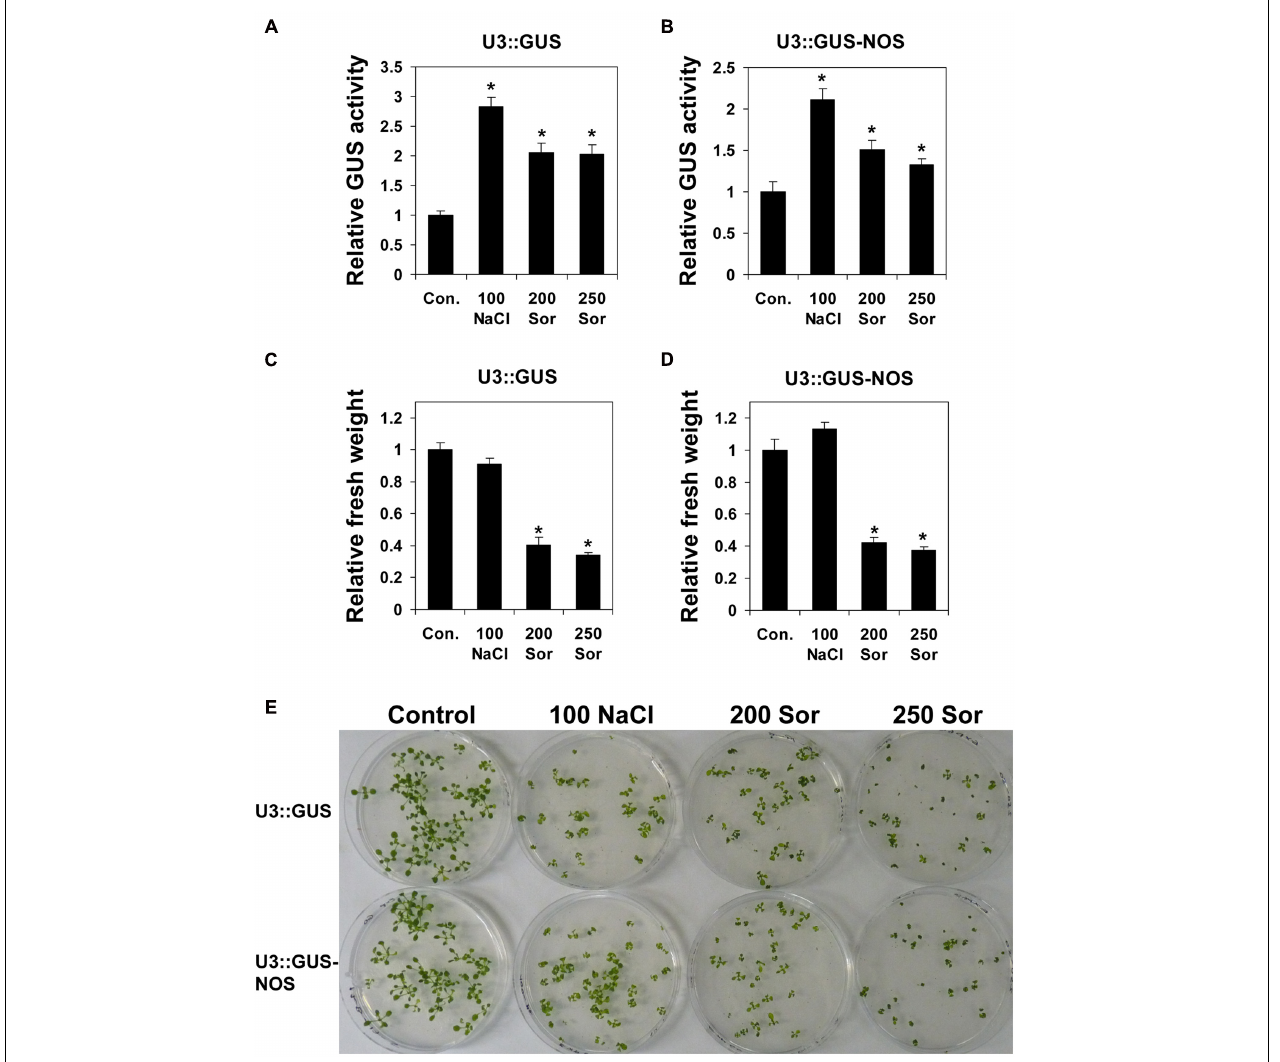
FIGURE 5 | Induction of UPF3 regulatory regions by salt stress. (A,B) WT (Col-0) plants expressing the U3::GUS (A) or U3::GUS-NOS (B) constructs were germinated on MS plates (control), or on plates containing 100 mM NaCl, 200 mM sorbitol, or 250 mM sorbitol. For each construct, we utilized homozygous transformed plants expressing a single copy of the transgene. Each column represents the mean GUS activity of 10 biological replicates. Each biological replicate was composed of ∼ 50 2-week-old plants grown on the same plate (thus, each column represents the average GUS activity of ∼ 500 plants). For each construct, data were normalized to the GUS activity of the control treatment. (C,D) The fresh weight of plants expressing the U3::GUS (C) or U3::GUS-NOS (D) constructs following the different treatments. Each column represents the mean fresh weight of 10 biological replicates. Each replicate was the average fresh weight of a single plant determined according to the weight and number of plants grown on a single plate (thus, each column shows the average weight of about 500 plants grown in 10 plates). All data were normalized to the control treatments. Error bars represent the SE. An asterisk indicates a significant difference ( p < 0.05) between the control and the NaCl or sorbitol treatments as determined by Student’s t -test. (E) Representative plates at the time of